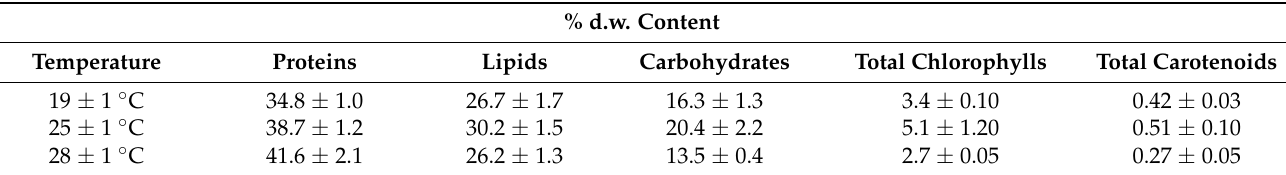
Table 9. Effect of temperature on biomass biochemical composition. % d.w.